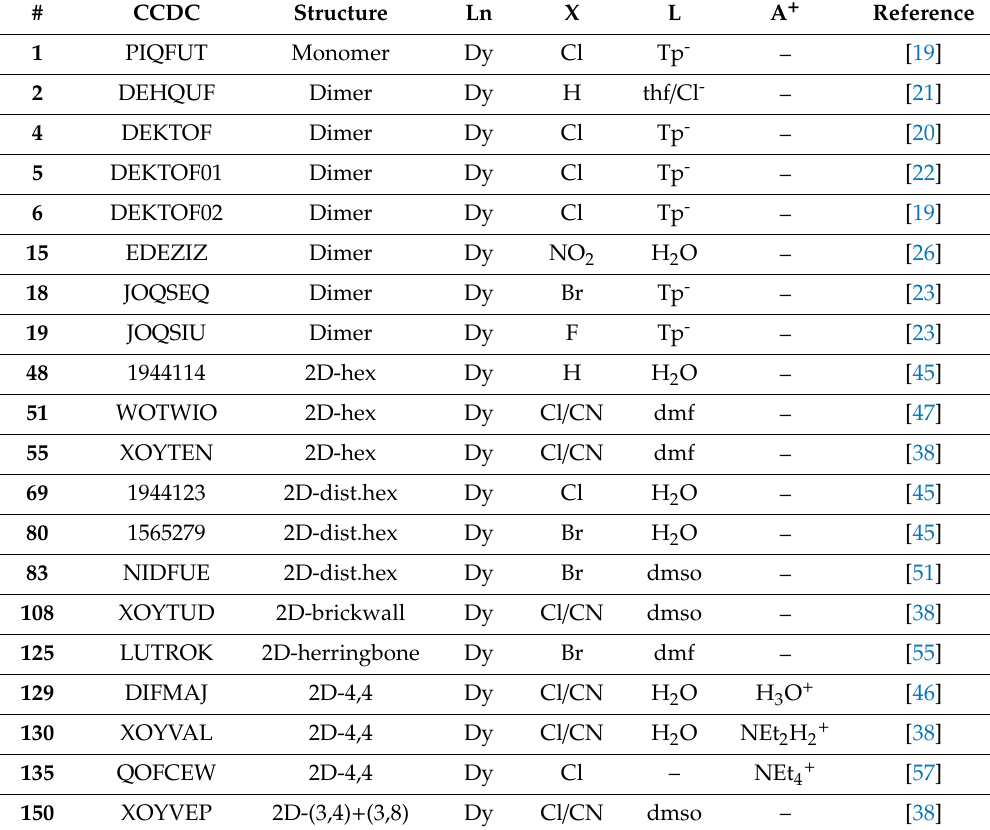
Table 22. Structurally characterized Dy(III) compounds with anilato